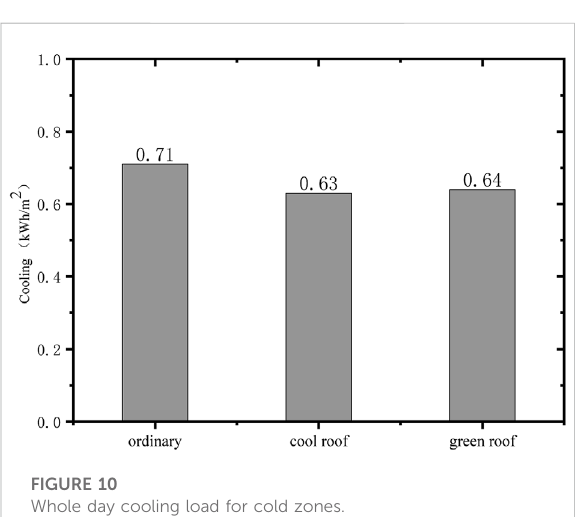
FIGURE 10 Whole day cooling load for cold zones.